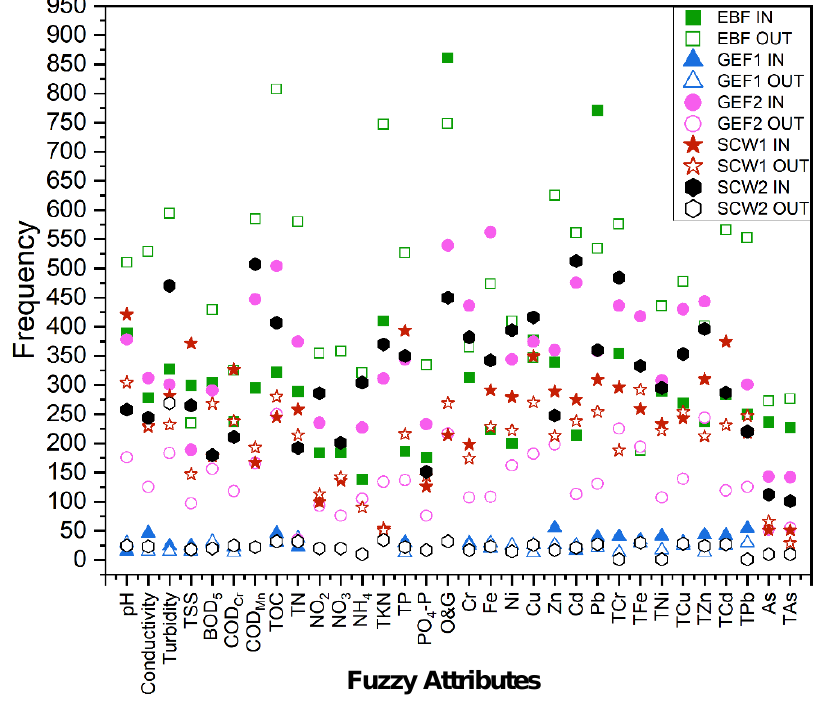
Figure 5. Parameter attributes of the bioretention system reducts.